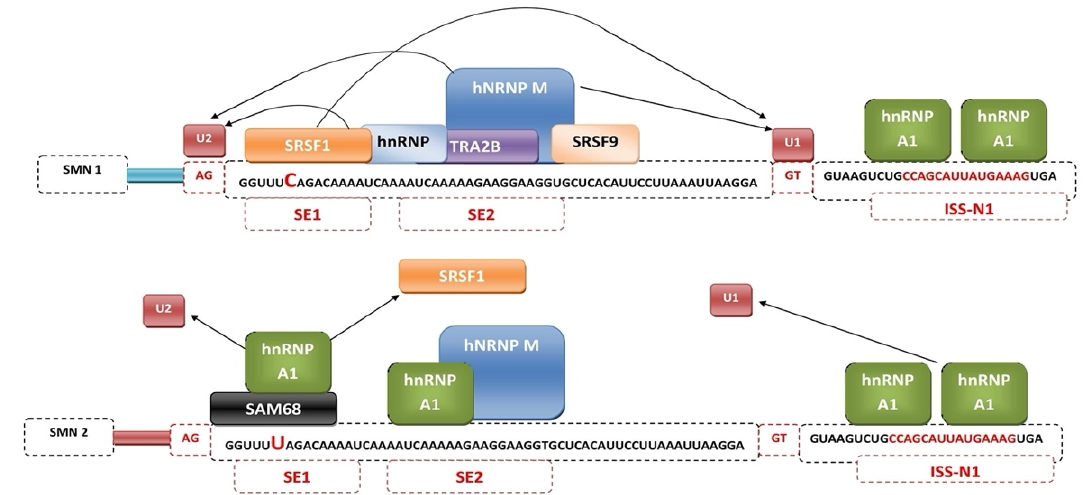
Figure 2. Mechanism of regulation of SMN1 and SMN2 gene splicing by splicing factors. Exon 7 skipping may be caused by increased activity of a regulatory sequence located at the 3 (cid:48) end of exon 7, called terminal stem loop 2 (TSL2). It exhibits inhibitory